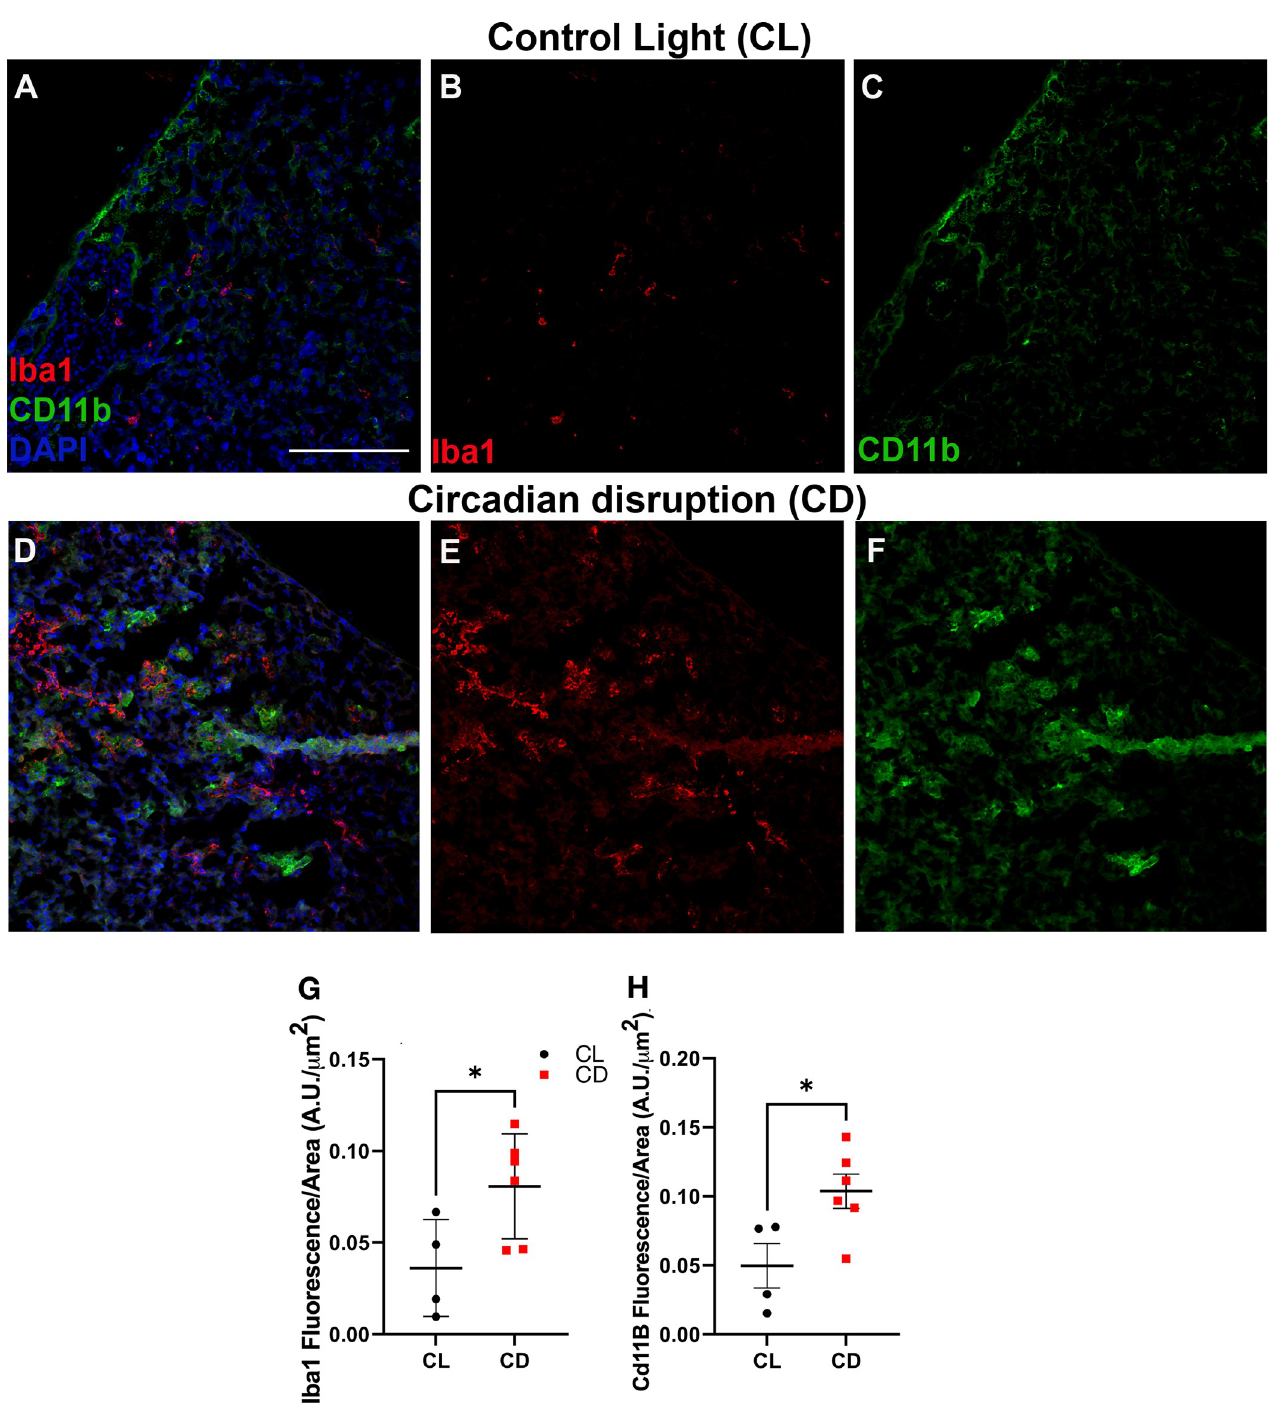
Fig 3. Chronodisruption causes increased macrophage and microglial signaling in the placenta. Placentas from ( A-C ) control light (CL) and mice exposed to ( D-F ) developmental chronodisruption (CD) were labeled for inflammatory markers labeling microglia and macrophages within the decidual zone. In placenta from CD mice increased placental ( G ) Iba1 fluorescence (Student’s 2-tailed unpaired t-test, t = 2.49, df = 8, p = 0.038) and increased placental (H ) CD11b fluorescence (Student’s 2-tailed unpaired t-test, t = 2.70, df = 8, p = 0.027) were detected. CL = 4 placenta from different dams, 3 images each; CD = 6 placenta from different dams, 3 images each. All data are presented as mean ± SEM, scale bar = 20 microns, and � = p < 0.05.